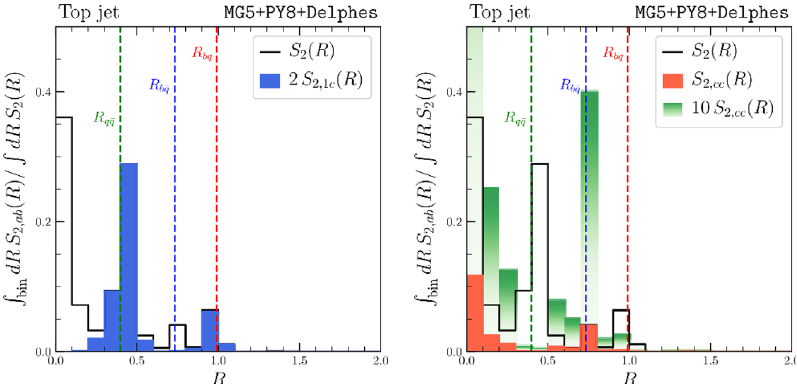
Figure 4. S 2 ; 1 c and S 2 ;cc distributions of the top jet in (cid:12)gure 2(a). The intensity of S 2 ;cc is much smaller than S 2 because the subleading p T jets have small transverse momenta. The magni(cid:12)ed distribution of S 2 ;cc is shown in the green histogram. The dashed lines are the characteristic angular scales at the parton